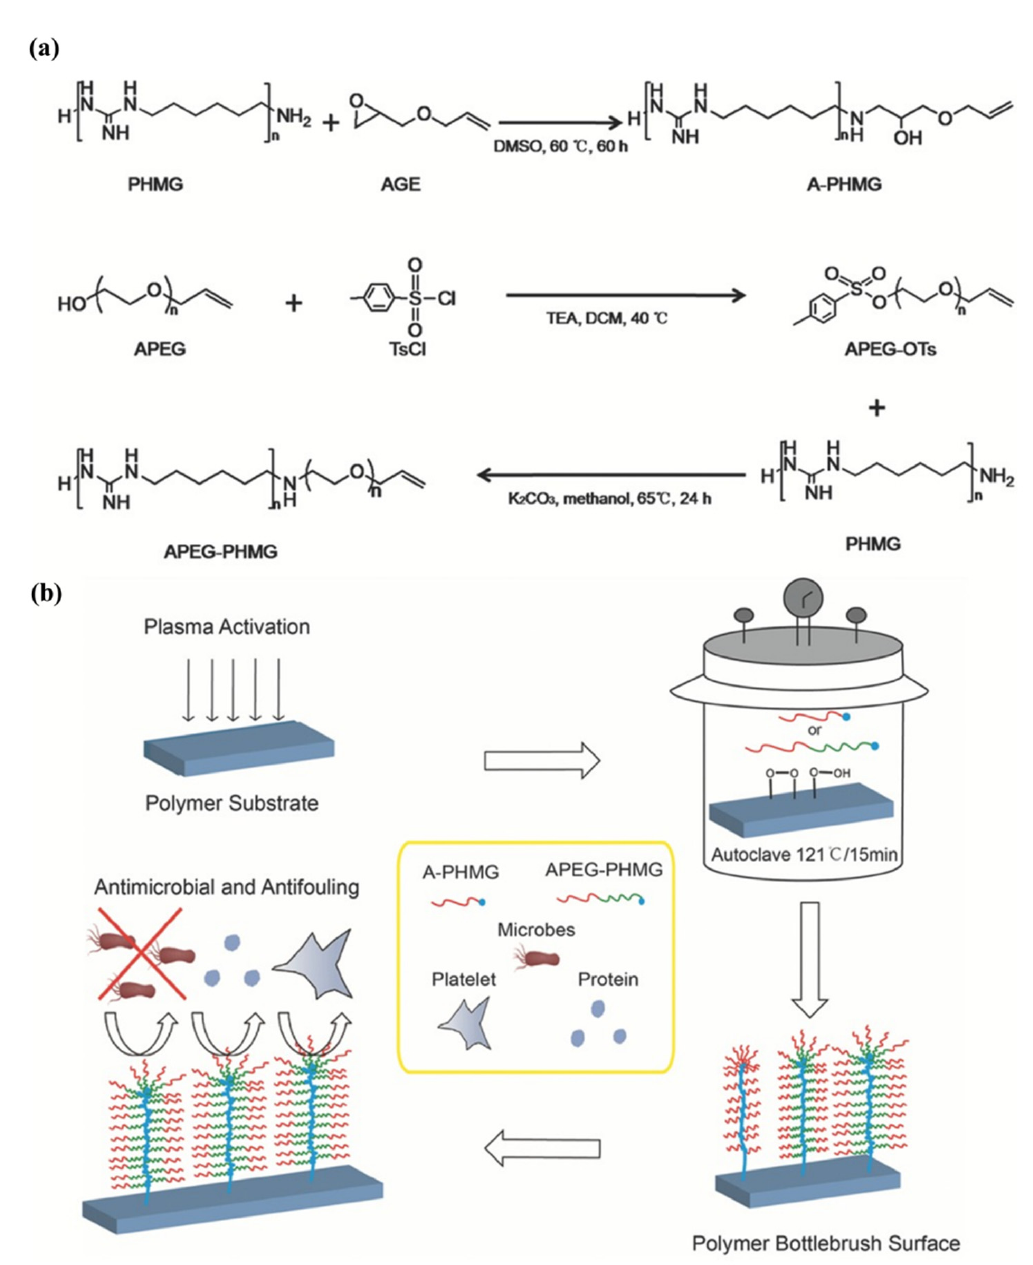
Figure 14. ( a ) Synthesis of A-PHMG and APEG-PHMG oligomers. ( b ) Schematic of plasma/autoclave-assisted grafting of A-PHMG/APEG-PHMG bottlebrushes on polymeric substrates as studied by Su et al. Reprinted with permission from [37]; published by Wiley, 2017.